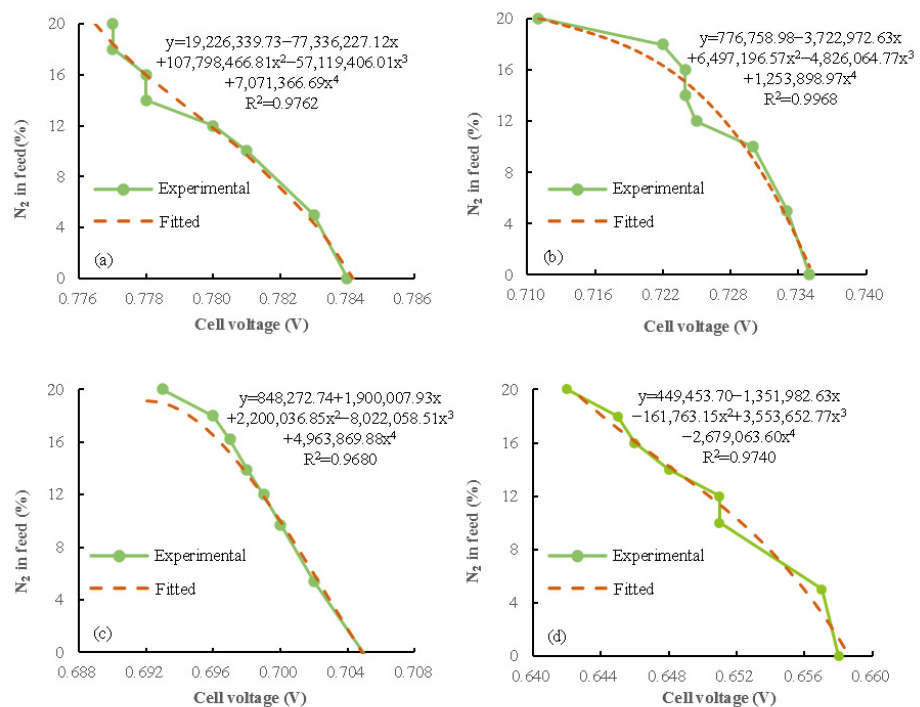
A ∙ cm − 2 ; ( d ) 1.4 A ∙ cm − 2 .